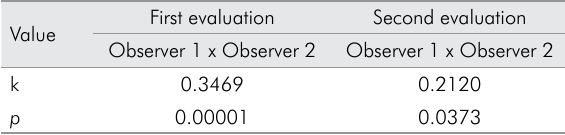
Table 1. Interobserver reliability.